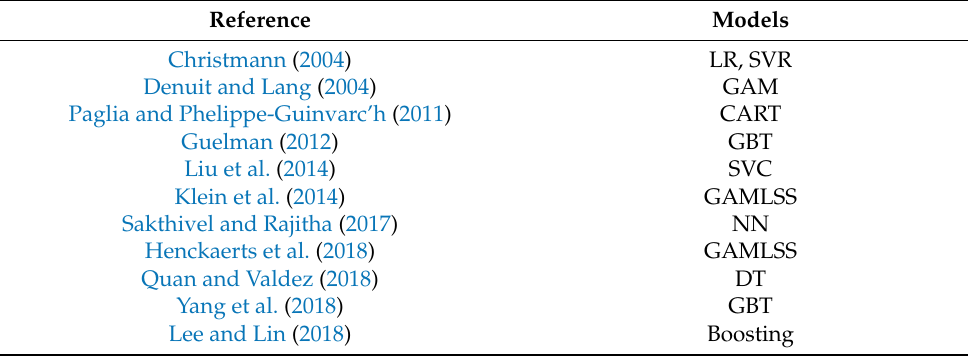
Table 2. Summary of contributions in